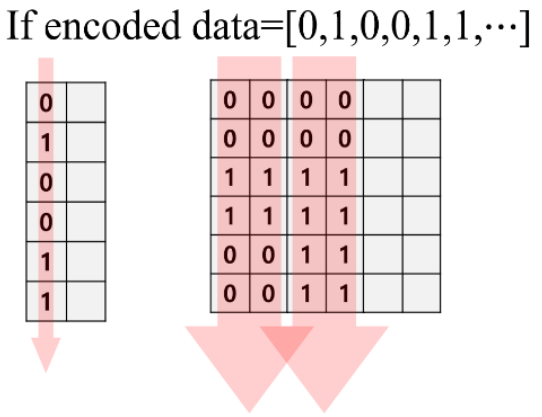
Figure 11. Comparison of the conventional and proposed repetitive data embedding method.